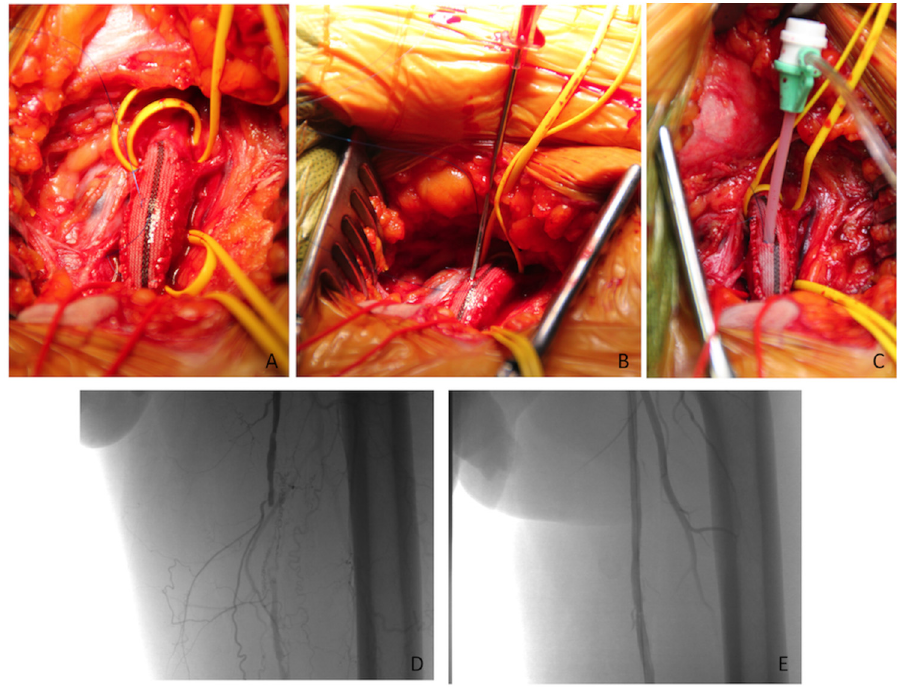
Figure 3. Intraoperative imaging showing ( A ) surgiclose placement in correspondence to a femoral dacron patch; ( B ) patch puncture using a bent 18G needle in antegrade direction; ( C ) placement of a 6F introducerin antegrade direction. ( D ) Angiography from the introducer through the patch positioned into the common femoral artery showing superficial femoral artery occlusion; ( E ) final angiographic result in correspondence of the superficial femoral artery.